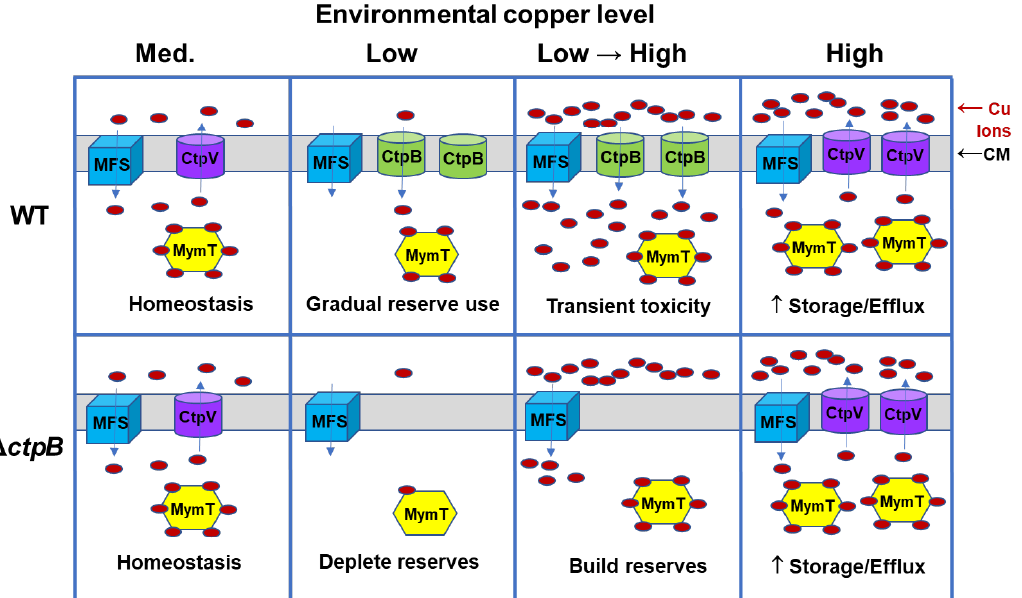
Figure 7. Model for CtpB function in M. tuberculosis copper uptake in various copper environments. Bacteria use major-facilitator superfamily (MSF) transporters to selectively import a wide range of divalent metals, including copper, across the cytoplasmic membrane (CM) using proton-motive force. Which M. tuberculosis MSF proteins function in copper uptake is unknown, but this pathogen is known to produce cytoplasmic metallothionein (MymT) to store intracellular copper ions and copper-efflux P-type ATPase CtpV for homeostatic control of intracellular copper levels. In a copper-poor environment, the copper (I)-import P-type ATPase CtpB is made to increase copper-uptake capacity, while ctpV expression is inhibited to minimize efflux. If the external environment rapidly changes from low to high copper, such as when a mycobacteria-containing phagosome fuses with a lysosome, the high capacity to import copper may be more detrimental to wild-type (WT) M. tuberculosis bacteria if copper import exceeds capacity for storage and efflux. Bacteria that survive respond to the elevated levels by increasing production of CtpV and MymT to restore copper homeostasis. In contrast to the WT , a Δ ctpB mutant is predicted to more quickly draw down its copper reserves in a low-copper niche, but restore its reserves without importing excess copper in a copper-toxic environment. Increased resistance to copper toxicity by Δ ctpB may enable the mutant to replicate to higher levels than the WT in mice, resulting in accelerated manifestation of disease pathology and host death.